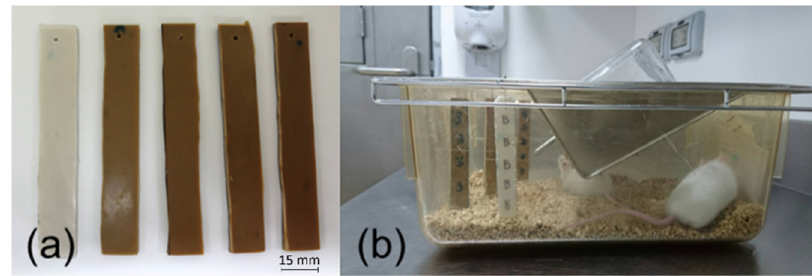
Figure 2. Experiment; ( a ) 2 rats for cage 1 and cage 2; ( b ) a rat in cage 3.